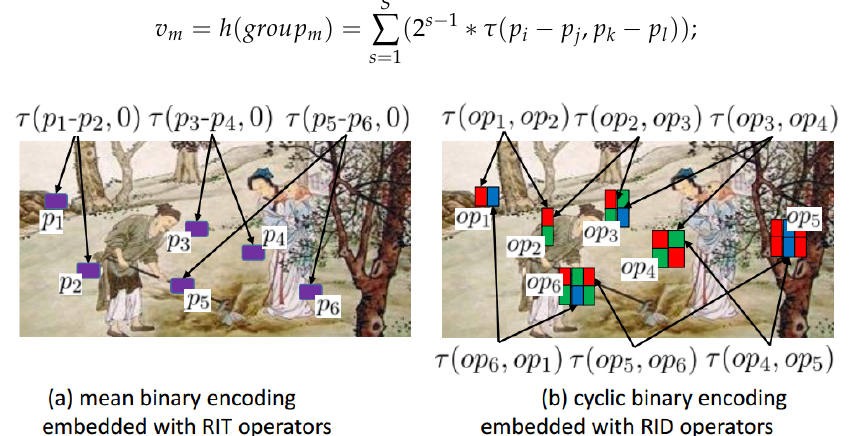
Figure 2. This figure shows the working process of binary encoding methods embedded with basic sampling operators. In the figure ( a ); each RIT operator just calculates the difference between two pixel regions: op RIT = P i − P j . The theoretical average value of RIT operator equals 0. Therefore, the encoding manner of mean binary encoding method is to compare each op RIT with the average. In the figure ( b ); each RID operator calculates the difference of several pixel regions. The number of regions may be different between different RID operators. The rgb color of each sampling region represents the corresponding sampling channel. The theoretical average of RID operator also equals 0. However, cyclic binary encoding method does not compare RID sample value with 0. It compares one RID sample value with another RID sample value, which is better than that of comparing with theoretical